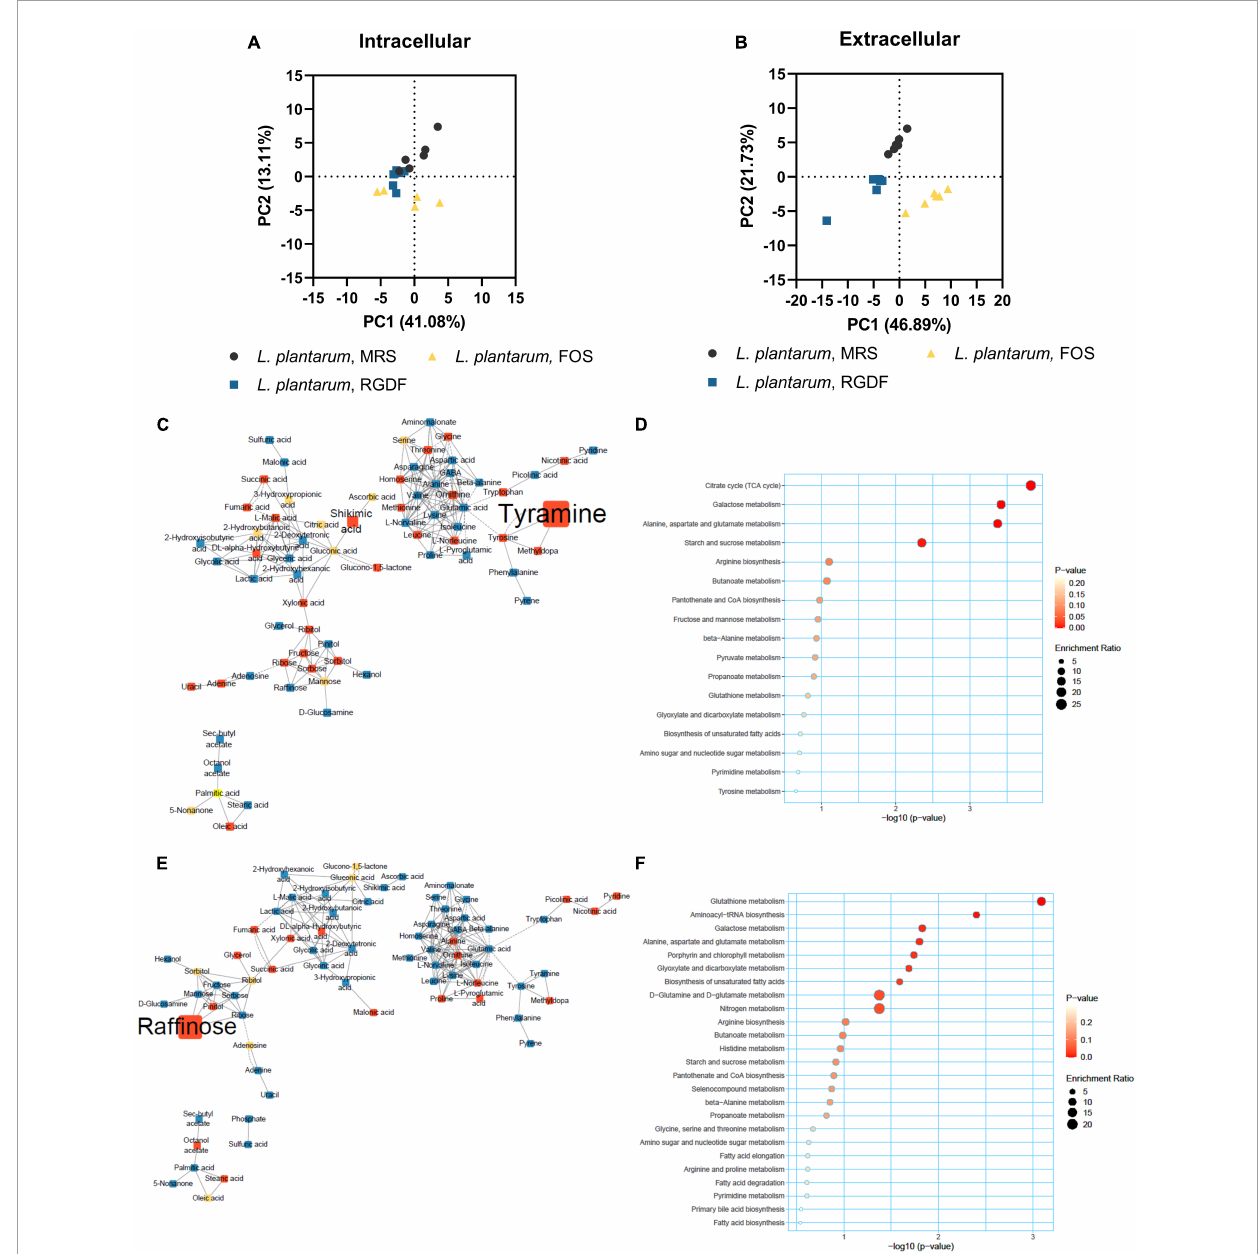
FIGURE5 Metabolomic analysis of L. plantarum cultured with 0.5% (w/v) RGDF or 0.5% (w/v) FOS. Principle component analysis (PCA) score and loading plots of intracellular (A) and extracellular (B) metabolome. MetaMapp of L. plantarum cultured with FOS compared to the control MRS broth (C) and cultured with RGDF compared to FOS (E) . Each node is a structurally identified metabolite. Blue nodes are decreased metabolites, red nodes are increased metabolites, and yellow nodes are unchanged metabolites. The size of nodes and labels reflect fold-changes and p -values by t